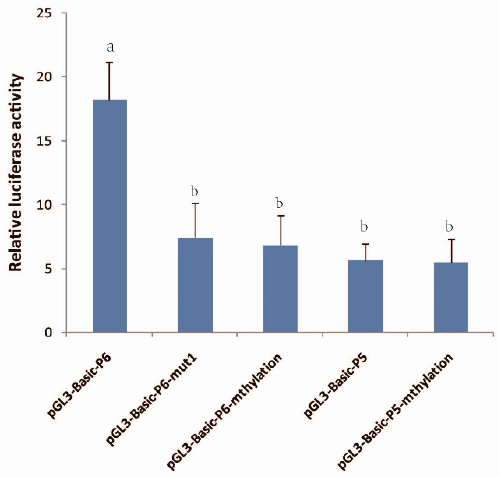
Figure 5. Verification of the effect of the mC-4 site by dual-luciferase. pGL3-Basic-P6-mut1 is site-directed mutation of mC-4; pGL3-Basic-P6-mthylation and pGL3-Basic-P5-methylation are under vitro-methylation; pGL3-basic-P5 and pGL3-basic-P6 are controls. Bars indicate means ± SD. Different superscripts indicate significant difference ( p < 0.05).